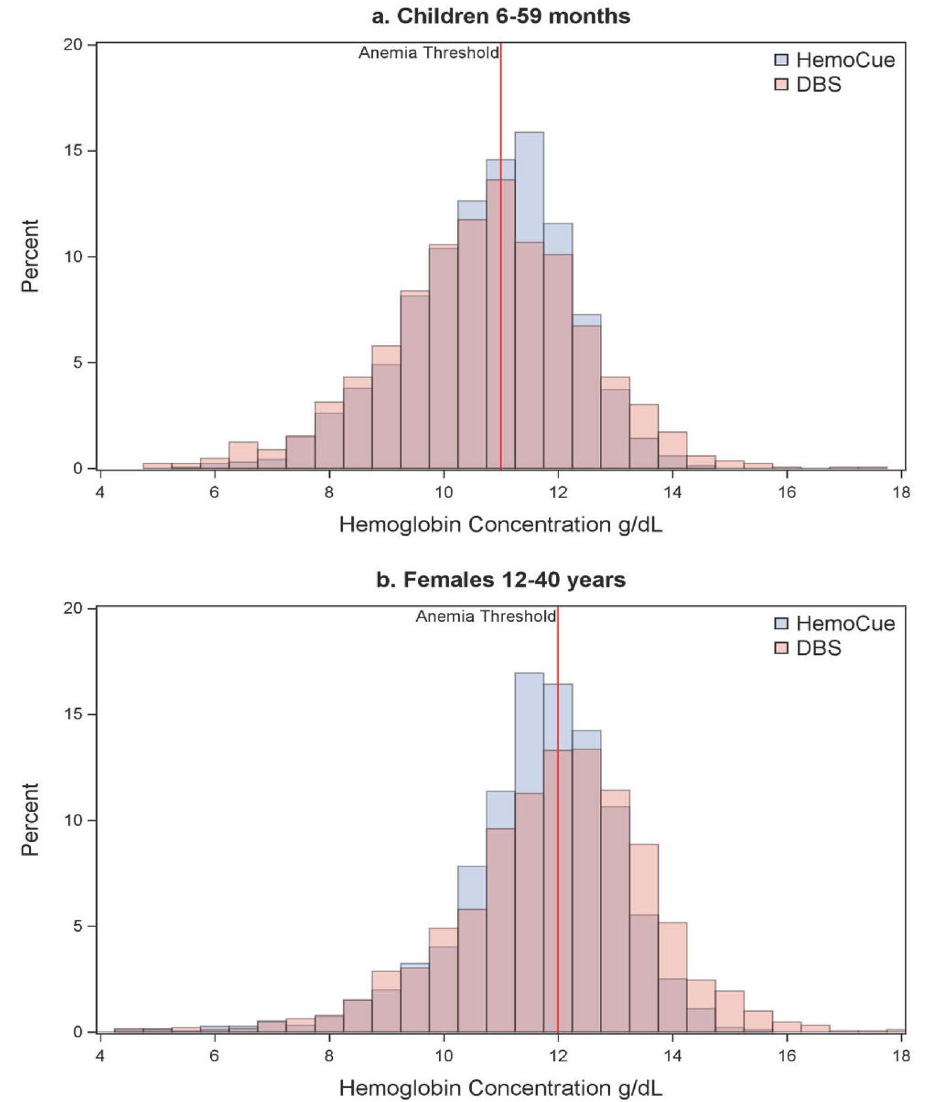
Figure 3. Overlaid histograms for Hb (g/dL) assessed by HemoCue and DBS for ( a ) children 6–59 months and ( b ) females 12–49 years, with the threshold for anemia shown in